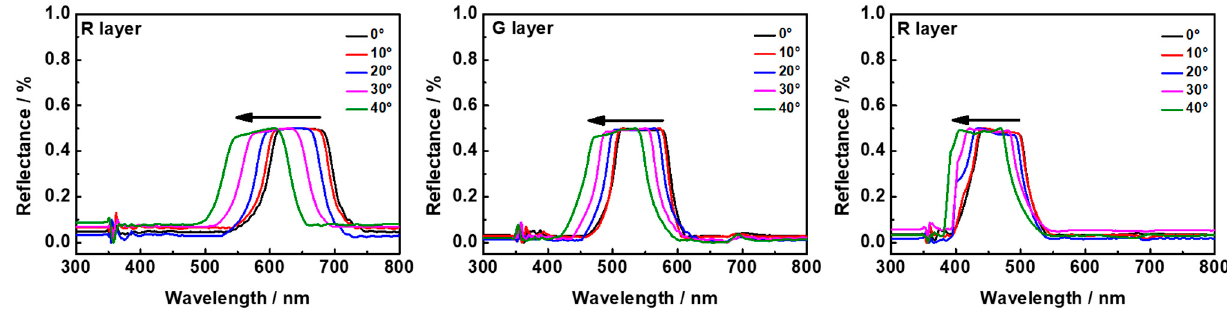
Figure 3. Reflectance spectra of the red (R), green (G), and blue (B) Ch layers with an increasing viewing angle.